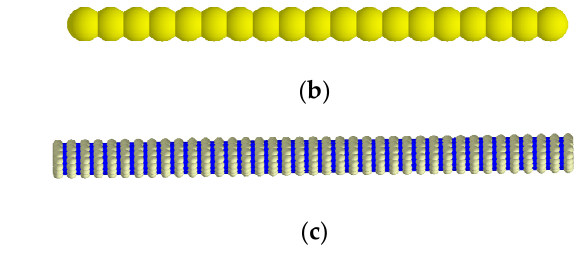
Figure 7. Rape stem flexible discrete element model. ( a ) Rigid discrete unit; ( b ) Rigid discrete element model; ( c ) Flexible discrete element model.